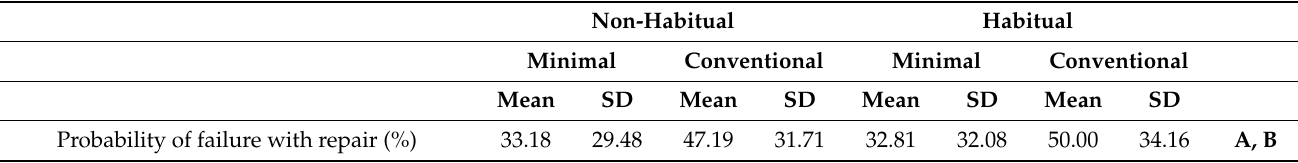
Table 6. Medial tibiofemoral cartilage failure probabilistic parameters. Non-Habitual